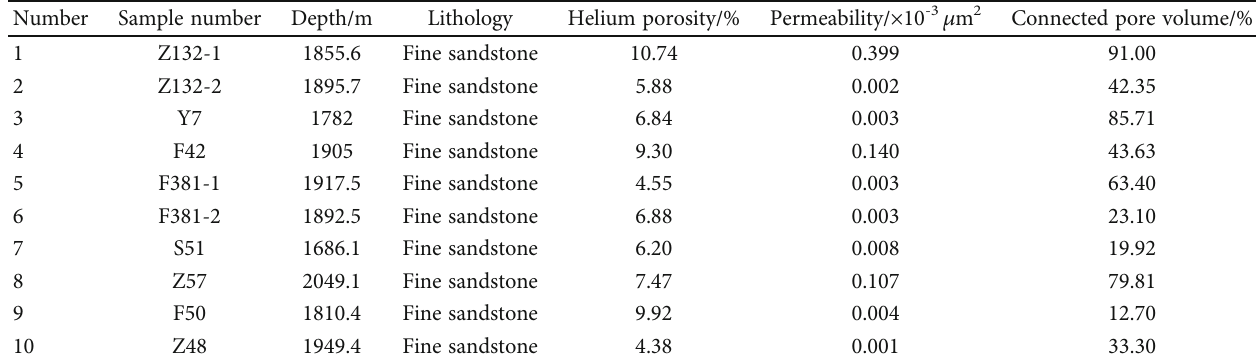
Table 1: Petrophysical pro fi le of tight sandstone